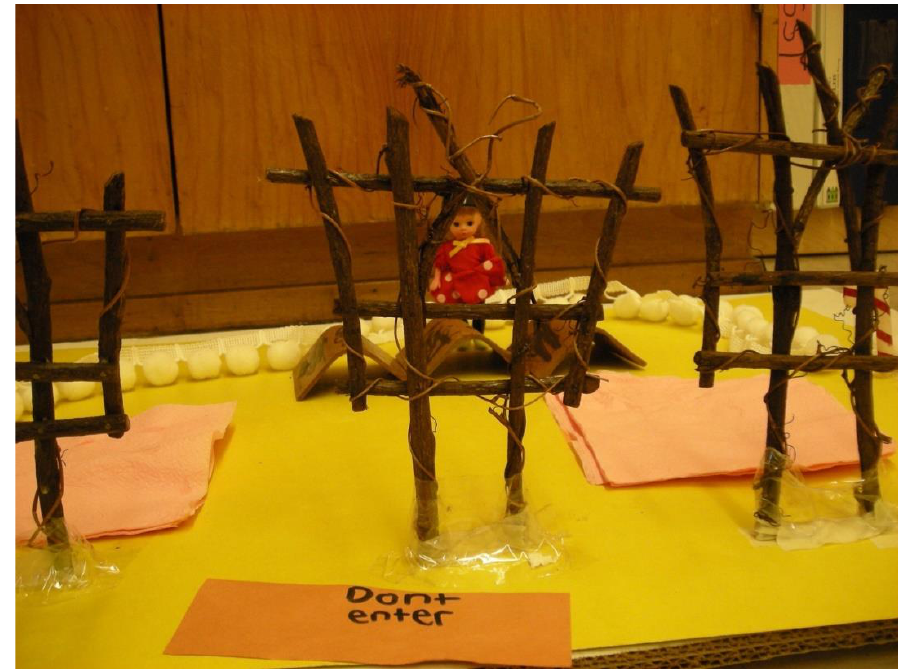
Figure 1. Working with a child in the school system.